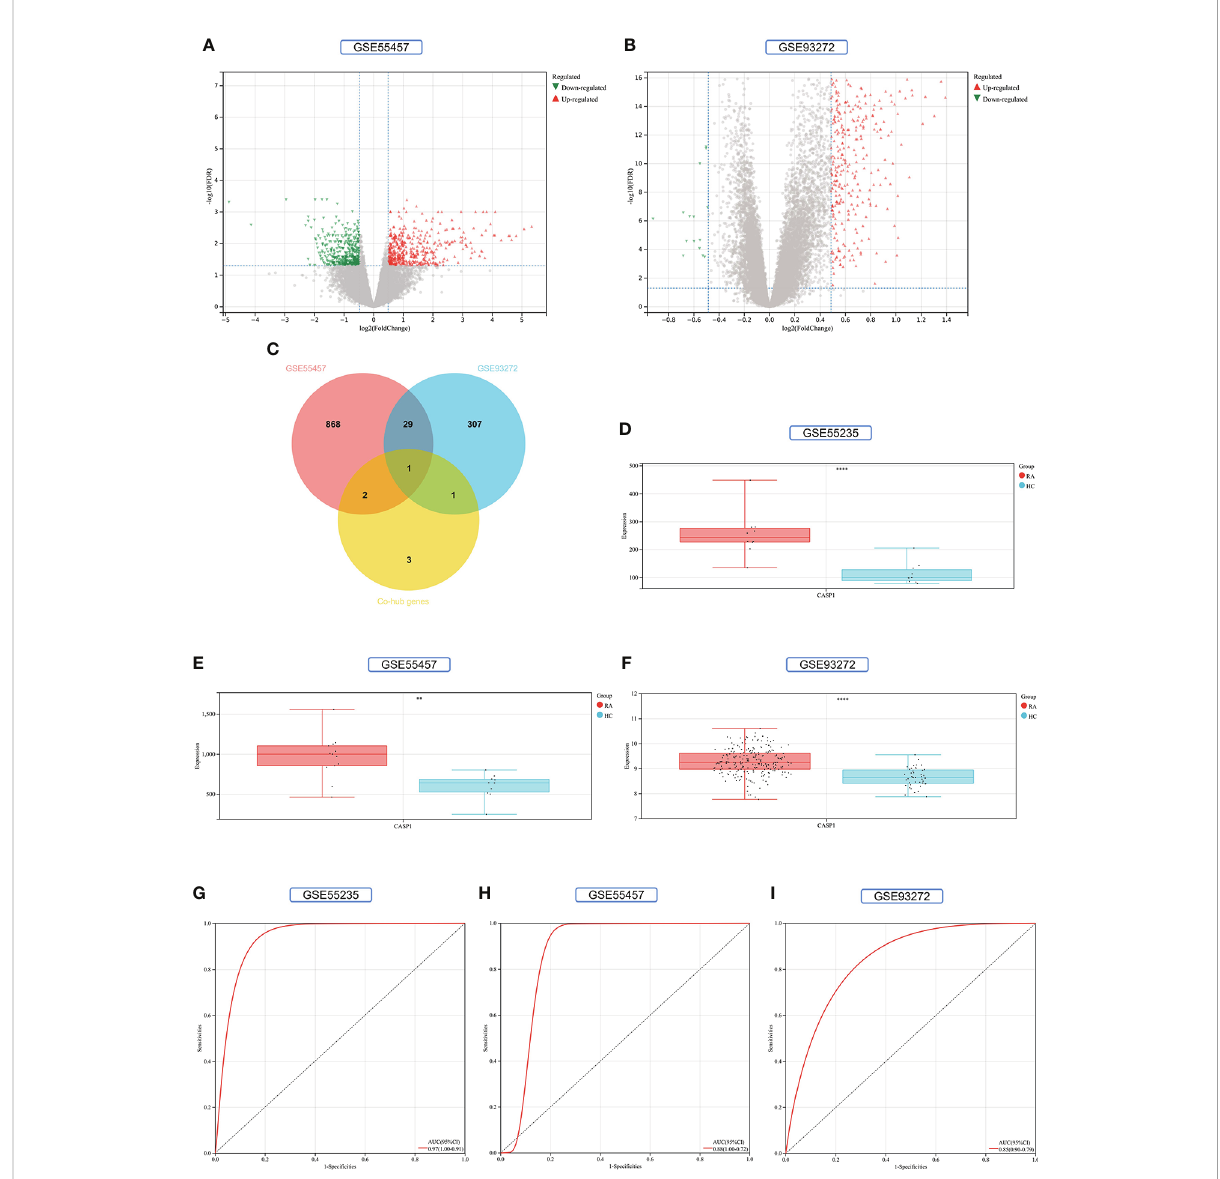
FIGURE 11 Screening and validation of key gene. (A) Volcano map of the GSE55457 dataset. (B) Volcano map of the GSE93272 dataset. Red triangles represent upregulated genes ( P < 0.05), green triangles represent downregulated genes ( P < 0.05), and gray dots represent genes not signi fi cantly differentially expressed across the RA and HC groups ( P > 0.05). (C) Venn-diagram of RA-DEGs of GSE55457 and GSE93272 with Co-hub genes. (D – F) Expression of CASP1 in the GSE55235, GSE5457, and GSE93272 datasets, Red for the RA group and cyan for the HC group (** P < 0.01 and **** P < 0.0001). (G – I) The AUC of the ROC curve veri fi es the diagnostic validity of CASP1 in GSE55235, GSE55457 和 GSE93272 ( P <